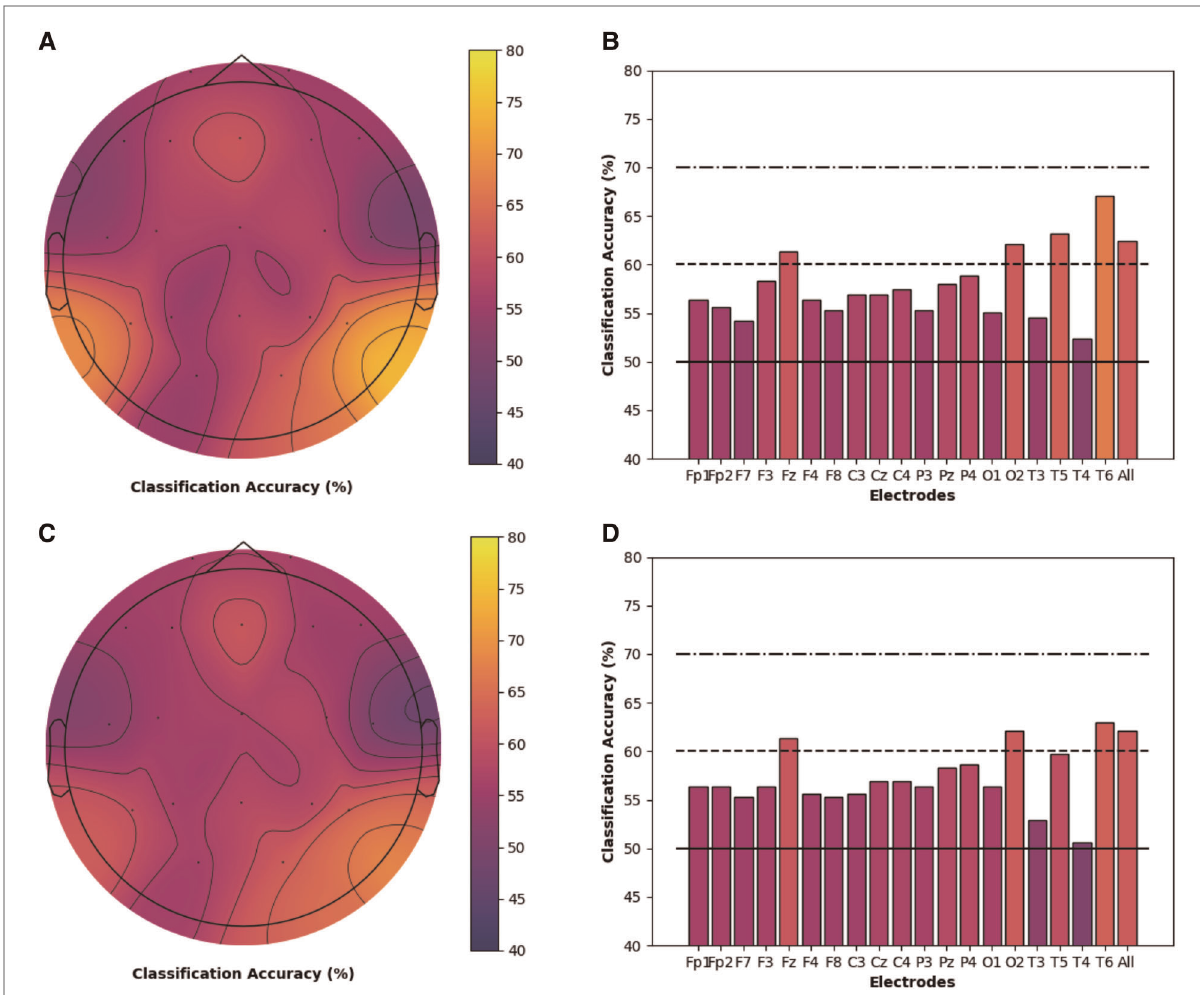
FIGURE 3 Individual electrode classi fi cation accuracy for chronic pain patients permutation entropy features (theta frequency band) . Pain vs. no pain classi fi cation accuracy for each individual electrode and across all electrodes for PE (theta band) features only in chronic musculoskeletal pain participants. Topographic maps and bar charts are displayed for SVM models ( A & B ) and logistic regression models ( C & D